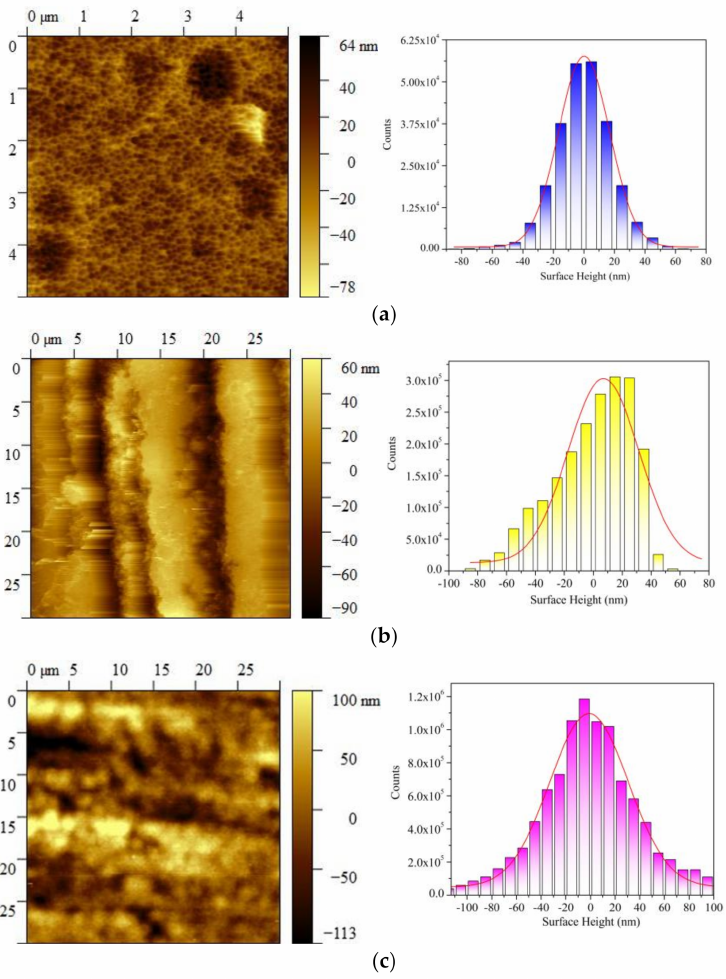
Figure 3. Atomic force microscopy (AFM) for the surface topography and surface roughness distri- bution. ( a ) The semiconductor die metallic pads; ( b ) the package substrate-I metallic pad; ( c ) the package substrate-II metallic pad.